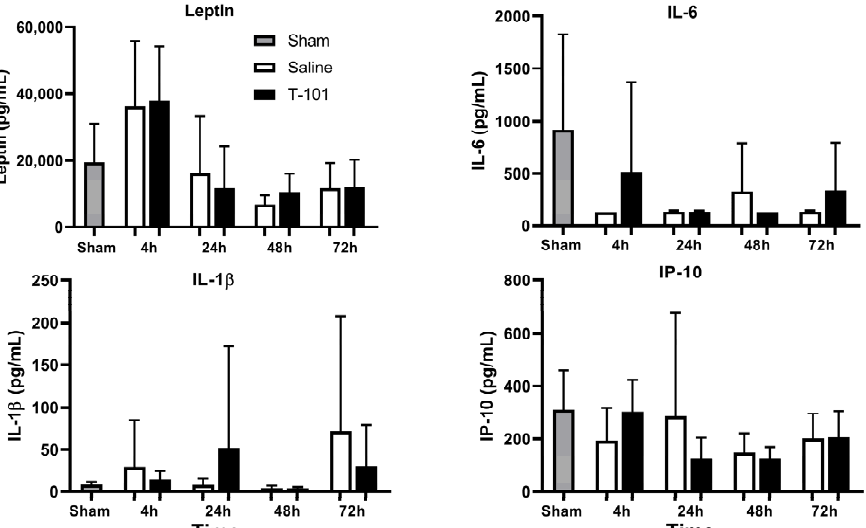
Figure 3. Systemic inflammation. Levels of leptin, interleukin-6 (IL-6), interleukin-1 beta (IL-1 β ), and inflammatory protein-10 (IP-10) were quantified from blood plasma collected for the sham group and injury groups at 4, 24, 48, and 72 h. Data are plotted as the mean ± standard deviation. There were no significant differences. Data compared by one-way ANOVA and the Bonferroni multiple comparison test. The analyzed groups included five animals (n = 5) per timepoint for the control and T-101 resuscitative fluid groups; five animals were analyzed in the sham